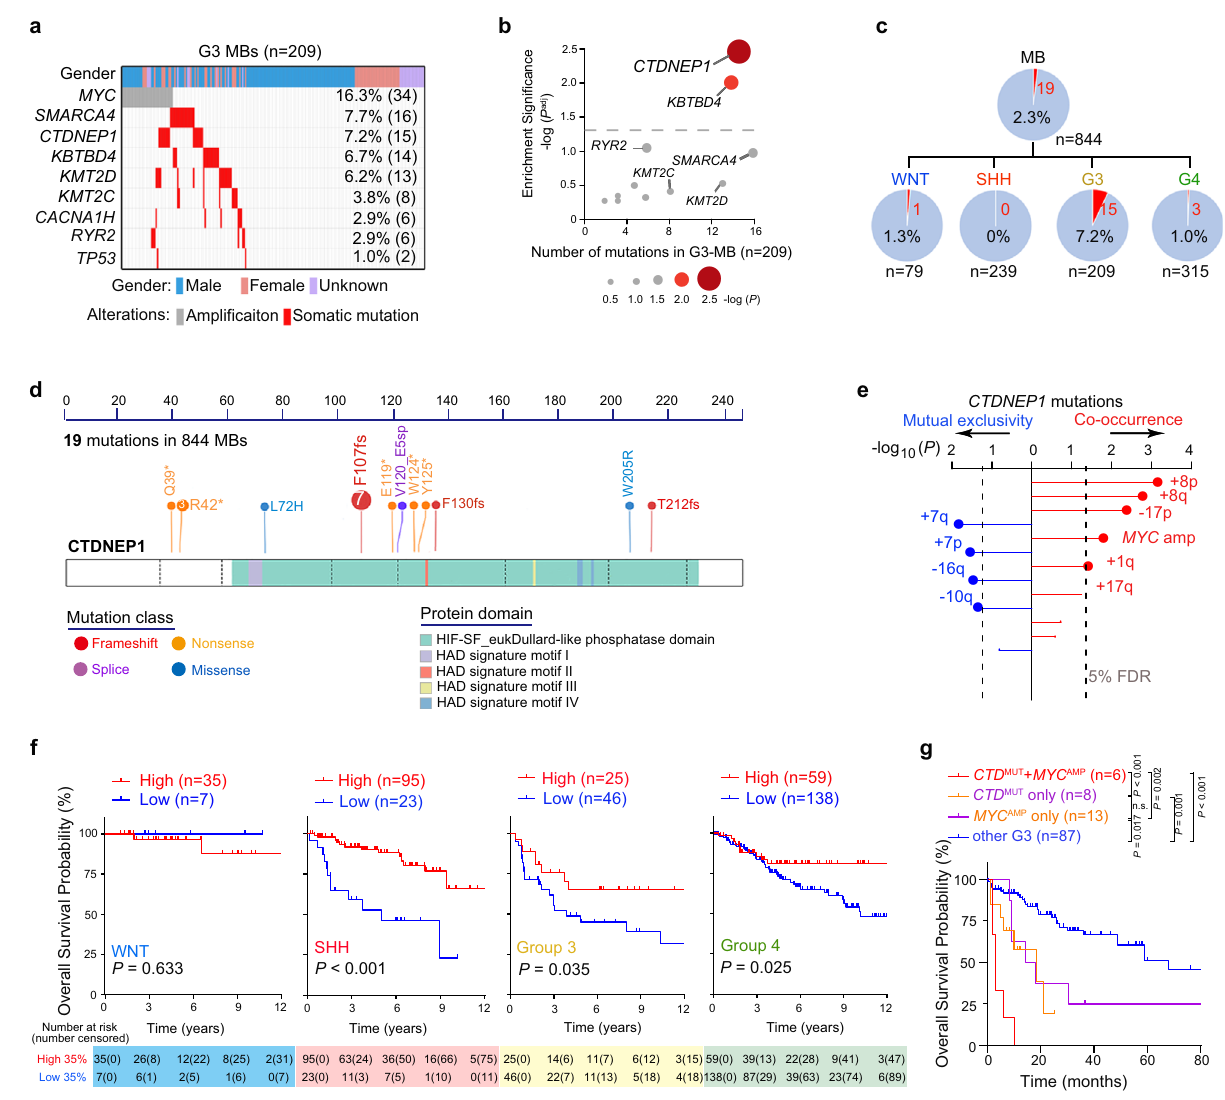
Fig.1|PrevalenceandclinicalimpactofrecurrentmutationsofCTDNEP1inG3 MBs. a Frequency of known and recurrent genetic variants in pediatric G3